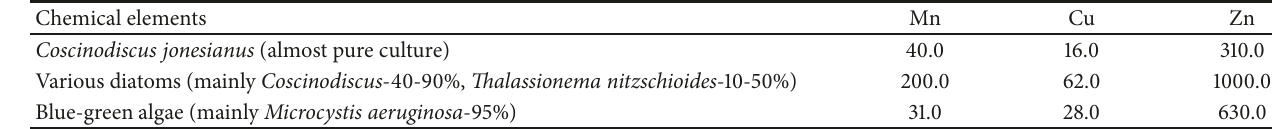
Table 5: Distribution of microelements in various types of phytoplankton of the Azov Sea, 𝜇 g/g of dry weight (after [32]). Chemical